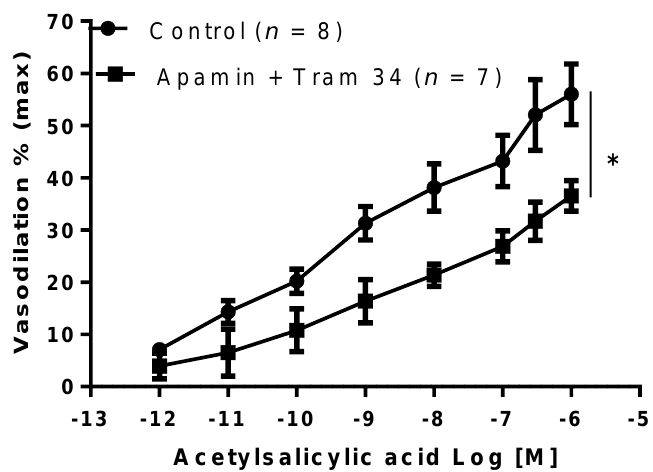
Figure 4 . Effect of acetylsalicylic acid on preconstricted arteries. Acetylsalicylic acid was tested on mesenteric arteries isolated from gravid rats , preconstricted with phenylephrine (Control) or with high KCl (80 mM), which induces depolarization (Depol). Data are reported as mean ± SEM, n = number of experiments, *** p < 0.001 (two-way ANOVA). In addition, vasodilation to aspirin was significantly reduced following pre-incubation with apamin (10 − 7 M, p < 0.05) and TRAM-34 (10 − 5 M, p < 0.05) blockers of SKca and IKca channels, respectively (Figure 5).